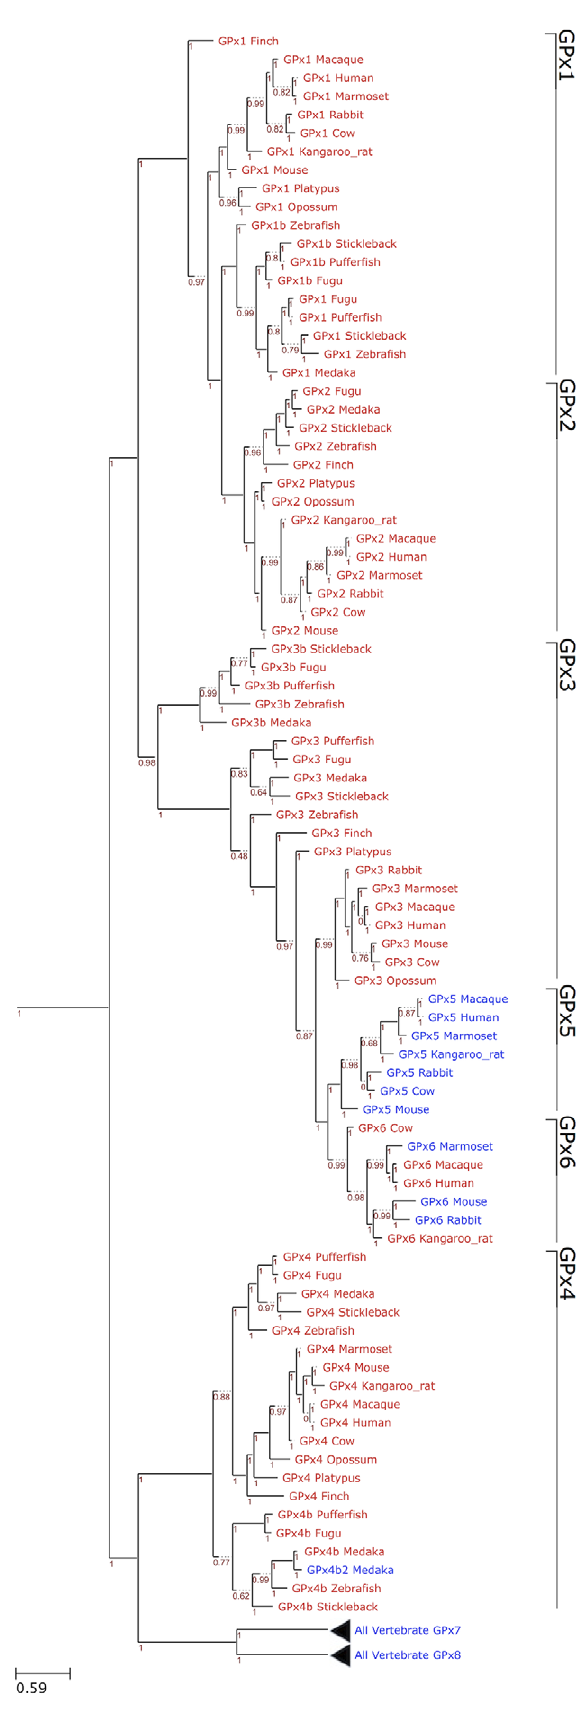
Figure 4. Phylogenetic tree of GPx family in eukaryotes. The figure shows a ML tree computed using the JTT substitution model. In the phylogram, Sec-containing proteins are shown in red and Cys- containing homologs are shown in blue. The GPx families are indicated on the right. The distance scale in substitutions per position is indicated at the bottom left. The branch support is shown in